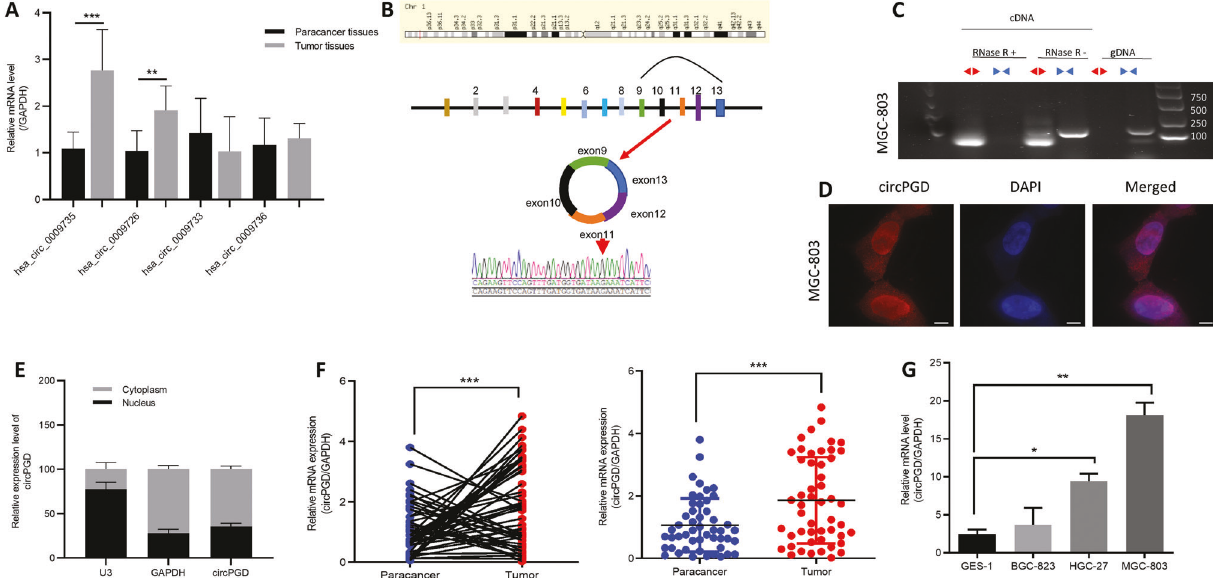
Fig. 1 CircPGD expression increases within GC cells and tissues. A Expression levels of PGD-derived circRNAs in GC tissues. B Sketch map showing circPGD forming by exonal circularization within PGD gene. According to PCR product sequencing, circPGD was spliced from the head to the tail. C Gel electrophoresis suggested that PGD existed in the canonical and back-spliced type with/without RNaseR application within gDNA and cDNA in GC cells. D and E Nuclear-cytoplasmic fractionation and RNA-FISH assay revealed the cytoplasmic and nuclear location of circPGD in MGC-803 cells, scale bars = 25 μ m. F Relative circPGD level in 50 paired fresh normal gastric tissues and GC tissues. G qRT-PCR detected circPGD levels within GES-1 cells as well as three GC cell lines. * p < 0.05, ** p < 0.01, *** p <